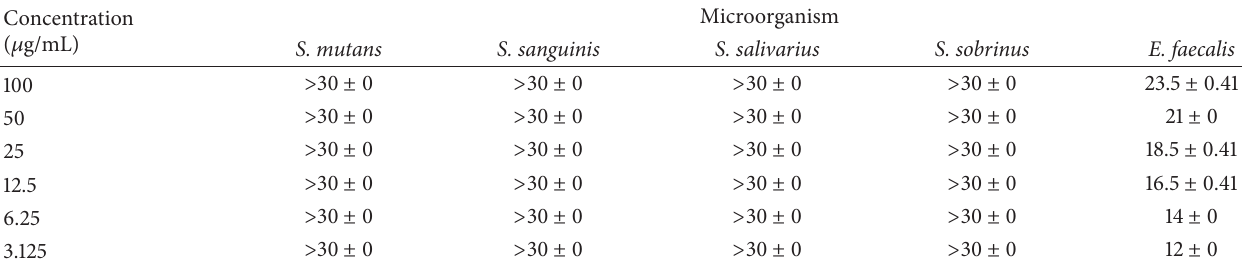
Table 4: The mean and SD of the diameter of growth inhibition zone (mm) due to the effect of 0.2% CHX on the five bacterial strains. Concentration ( 𝜇 g/mL)